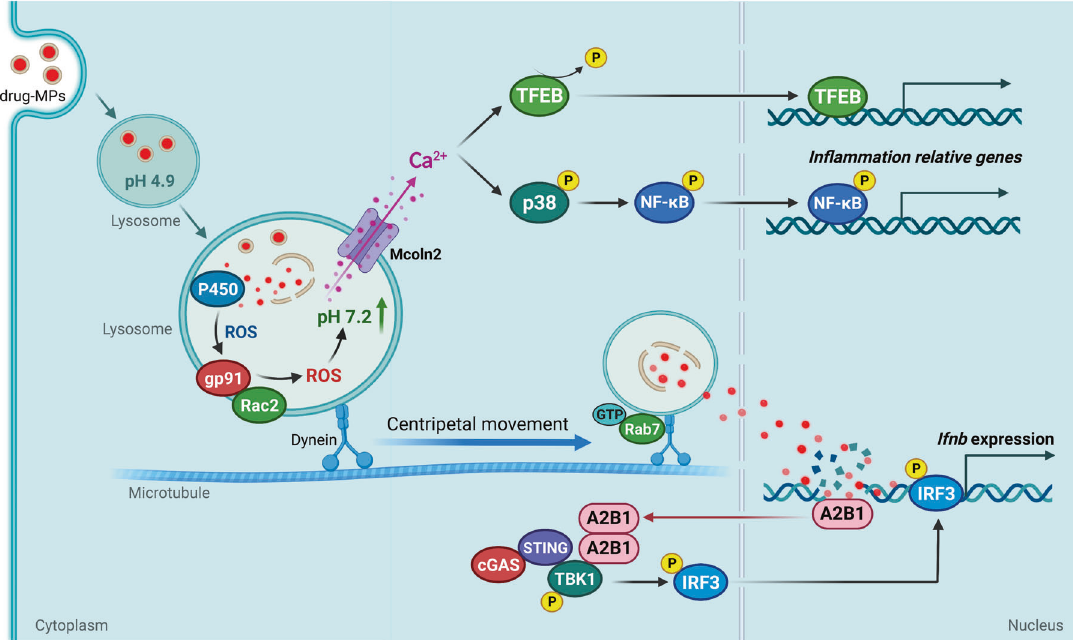
Fig. 8 The schematic diagram of drug-MPs resetting antitumor activity of macrophages. Drug-MPs increase TAMs lysosomal pH by activating lysosomal P450 monooxygenases and NOX2, causing Ca 2 + release via the lysosomal Ca 2 + channel mucolipin 2 (Mcoln2), which induces the activation of p38, NF- κ B, and TFEB, thus polarizing TAMs to produce in fl ammatory cytokines. Meanwhile, drug molecules are delivered by the lysosomes into the nucleus, where they activate DNA sensor hnRNPA2B1 for IFN- β production. This fi gure created with